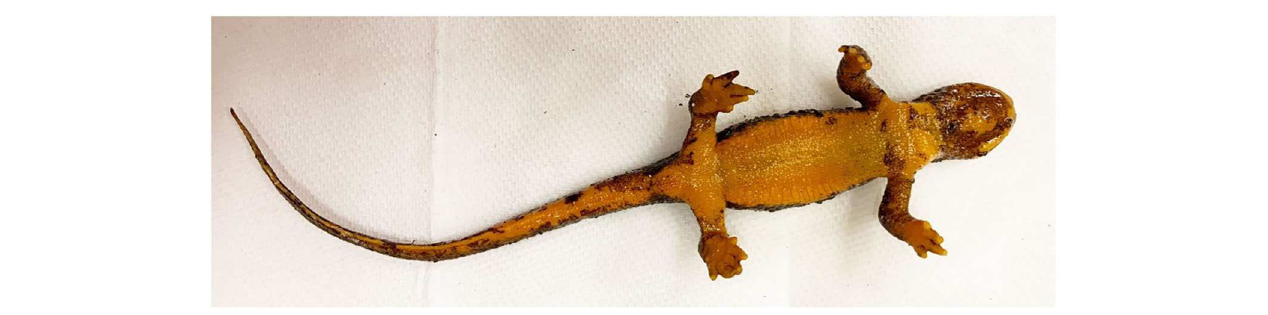
FIGURE1 Batrachochytrium salamandrivorans exposed, clinically diseased Taricha granulosa with severe, multifocal skin sloughing especially prominent on the chin, neck, legs, feet, and tail